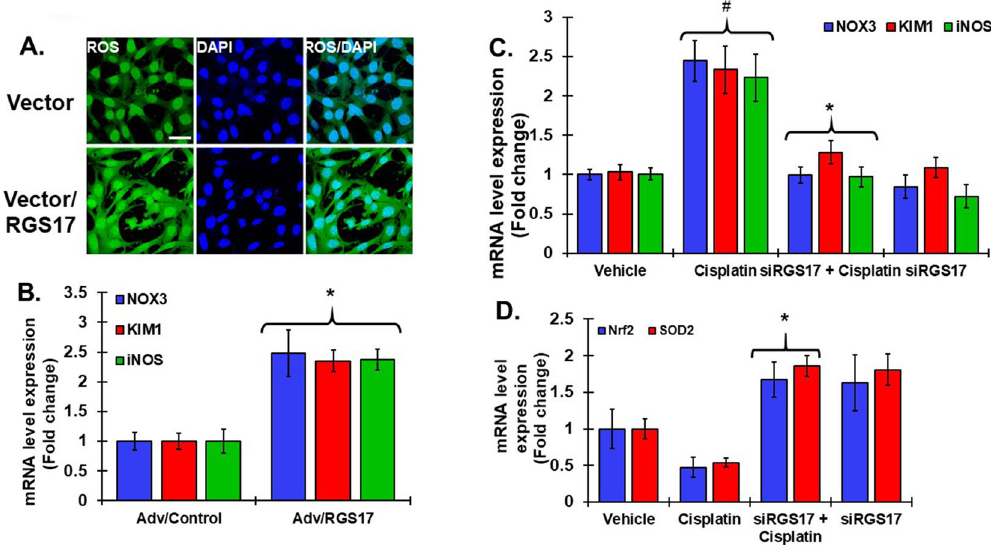
Figure 7. RGS17 regulates oxidative stress in the cochlea. ( A ) UB/OC1 cells were transiently transfected with empty vector or RGS17 plasmid for 72 h. ROS (green) generation was assessed using the CellROX assay. The cells were incubated with CellROX (5 µM) for 30 min, washed with PBS and fixed in 4% paraformaldehyde, mounted and imaged by confocal microscopy. RGS17 -transfected cells showed significant increases in ROS. ( B ) Gene expression was assessed via real-time qPCR analysis, conducted in the cochleae collected from treated rats. Expression of oxidative stress genes such as NOX3 , iNOS and KIM1 significantly increased in cochleae infected with adenoviral vector overexpressing RGS17 compared to control vector. *p < 0.05 versus control. ( C ) Expression of NOX3 , iNOS and KIM1 were significantly elevated after cisplatin treatment but was blunted following pretreatment with siRGS17 administered 2 days prior to cisplatin exposure. ( D ) mRNA levels of antioxidant genes Nrf2 and SOD2 were reduced by cisplatin and increased significantly by pretreatments with rats pretreated with siRGS17 . siRGS17 added alone elevated the levels of Nrf2 and SOD2 . Data indicate fold change in the mRNA levels ± SEM (N ≥ 3). For ( C ) and ( D ), # p < 0.05 versus vehicle or Adv/control. *p < 0.05 versus cisplatin, two-way